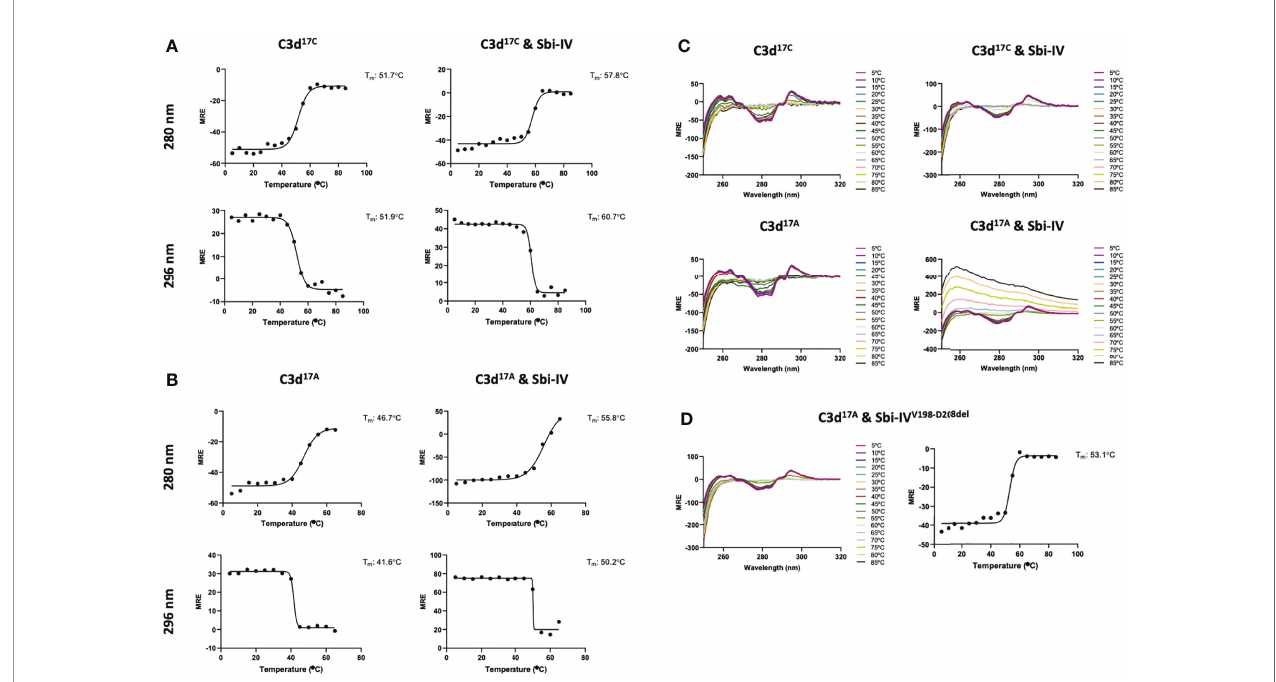
FIGURE 2 | Near-UV thermal melt circular dichroism spectroscopic studies of C3d 17C in the absence or presence of wild-type Sbi-IV. (A) Melting temperature (T m ) calculations for C3d 17C in the absence (Left) and presence (Right) of Sbi-IV, illustrated as Boltzmann sigmoidal fi ts of thermal denaturation curves at 280 nm (Top) and 296 nm (Bottom), showing an increase in T m of 6°C and 9°C at 280 and 296 nm respectively when Sbi-IV is present. (B) Melting temperature (T m ) calculations for C3d 17A in the absence (Left) and presence (Right) of Sbi-IV, illustrated as Boltzmann sigmoidal fi ts of thermal denaturation curves at 280 and 296 nm, this shows an increase in T m of ~9°C and at 280 and 296 nm respectively when Sbi-IV is present. MRE: mean residue ellipticity (deg cm 2 dmol -1 residue -1 ). (C) CD spectra showing that C3d 17A in the presence of wild-type Sbi-IV undergoes aggregation and precipitation at high temperatures (D) . Precipitation of C3d 17A is not observed in the presence of a truncated Sbi-IV mutant (Sbi-IV V198-D208del ), lacking the N-terminal region of Sbi-IV helix a 1, and Sbi-IV single mutant S199A. A T m increase of 6.5° C indicates that the truncated Sbi-IV V198-D208del mutant hasn ’ t lost its ability to bind C3d 17A